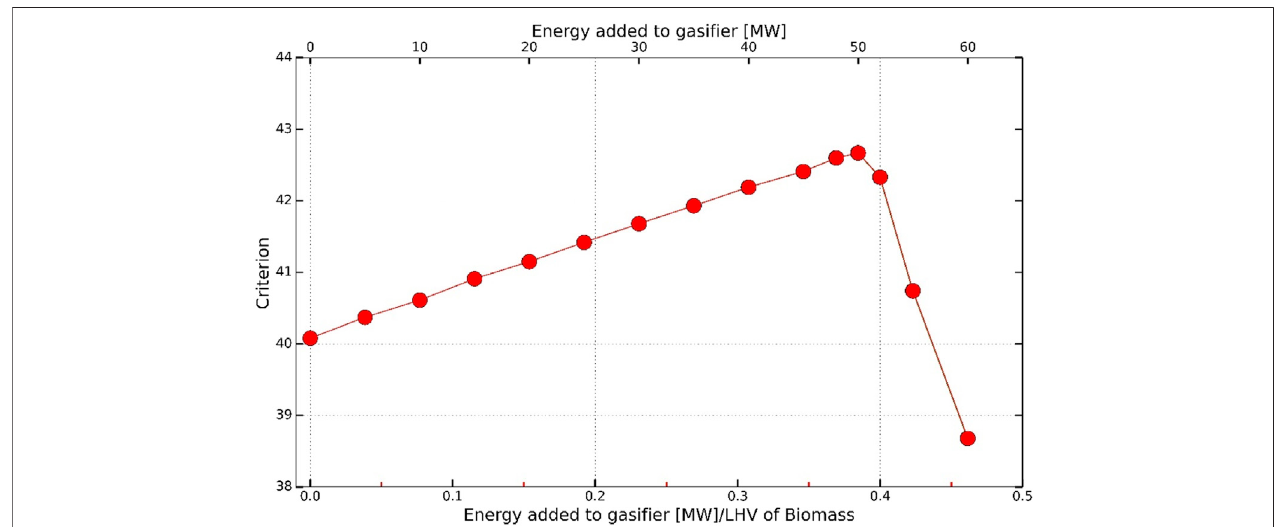
FIGURE 6 | Effect of energy added to the gasi fi er on the criterion de fi ned in Eq. 5 with SOEC as electrolysis unit.